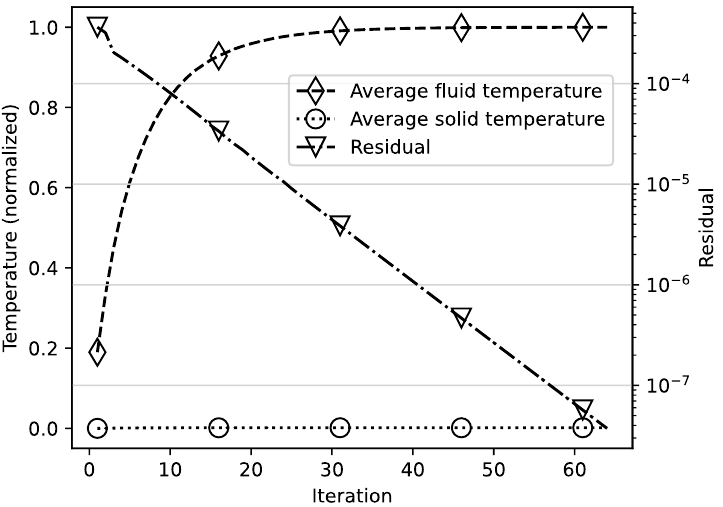
Figure 3. Residual and volume-averaged temperatures of fluid and solid for the steady-state simula- tion of the basic simulation. The simulation fulfilled all stopping criteria after 64 iterations.